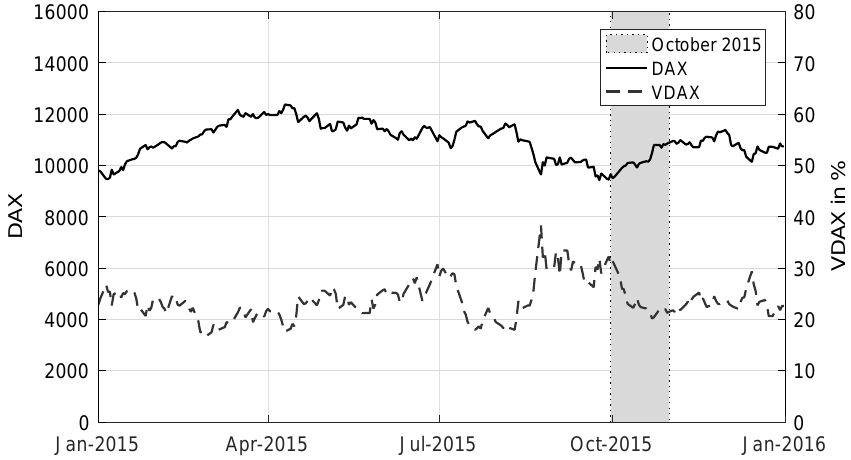
Figure 2. DAX and VDAX Index (January 2015–December 2015). Levels of the DAX and its volatility index VDAX are displayed during the period January 2015–December 2015. The grey-shaded area indicates the month October 2015 where the securities of our sample are